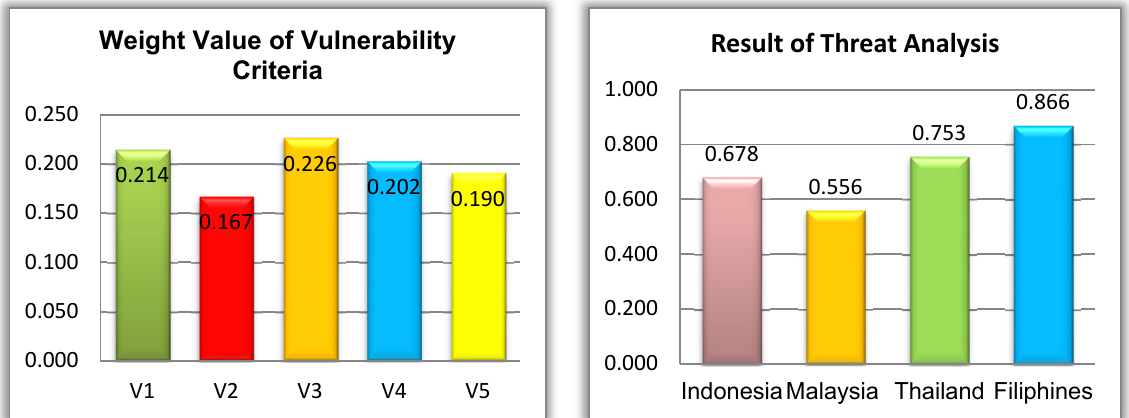
Fig. 3. Graphical Analysis of Vulnerability Criteria Fig. 4. Graph of Threat Aspect for Risk Analysis Score (T)